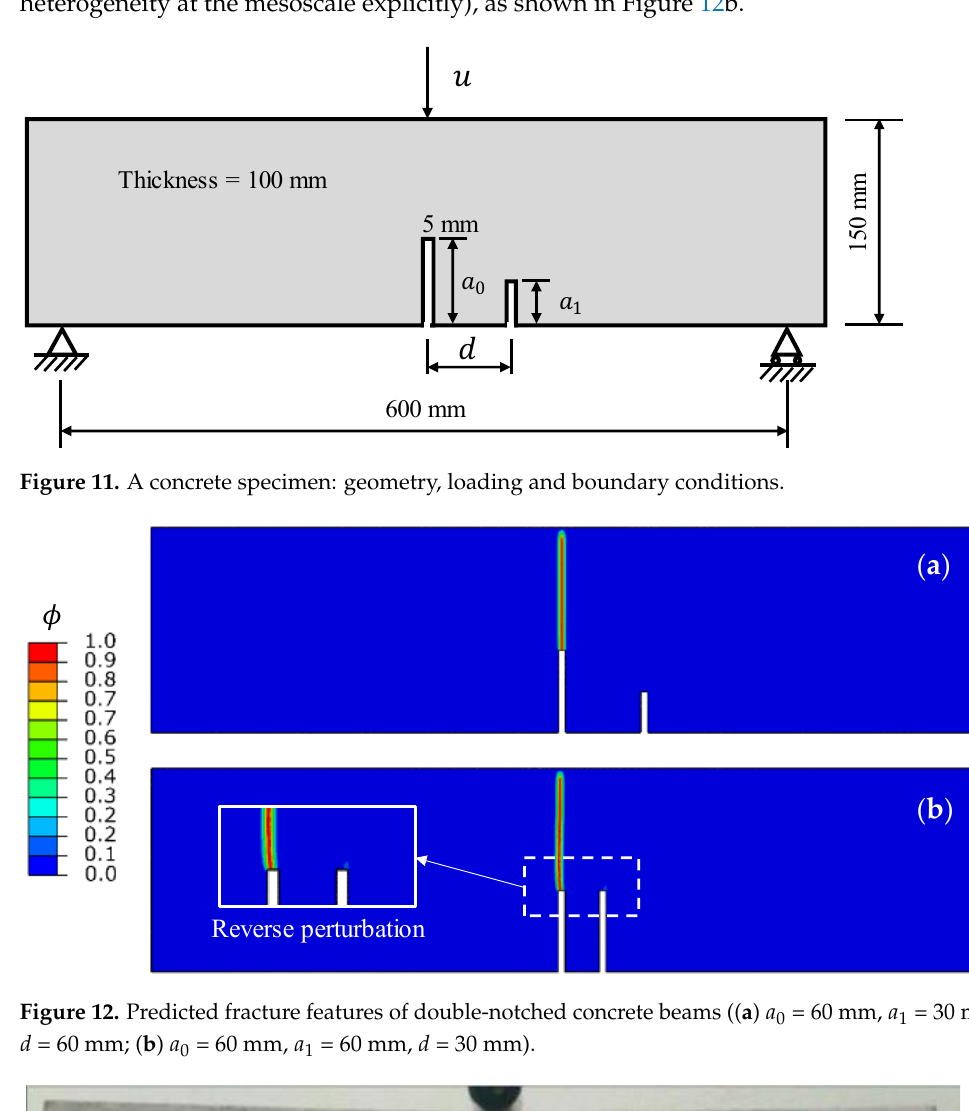
Figure 12. Predicted fracture features of double-notched concrete beams (( a ) 𝑎 0 = 60 mm, 𝑎 1 = 30 mm, 𝑑 = 60 mm; ( b ) 𝑎 0 = 60 mm, 𝑎 1 = 60 mm, 𝑑 = 30 mm).